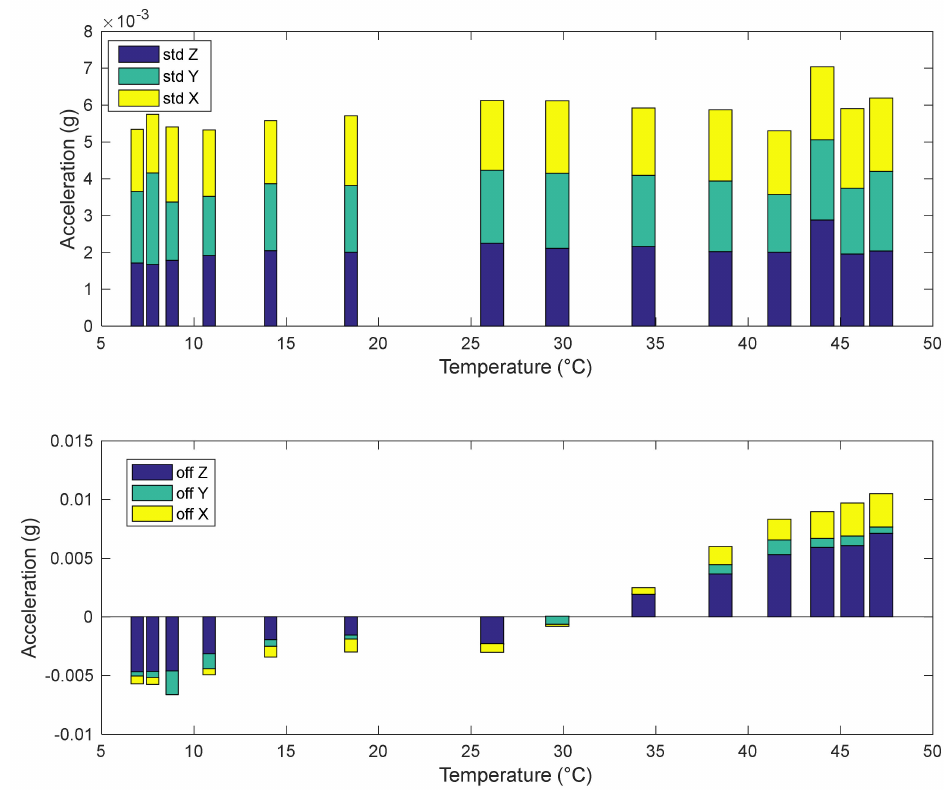
Figure 16. Standard deviation ( top ) and offset ( down ) behaviour as a function of temperature for the accelerometer outputs (axes). Standard deviations and offsets ( down ) are evaluated over mobile windows of about 16 min.